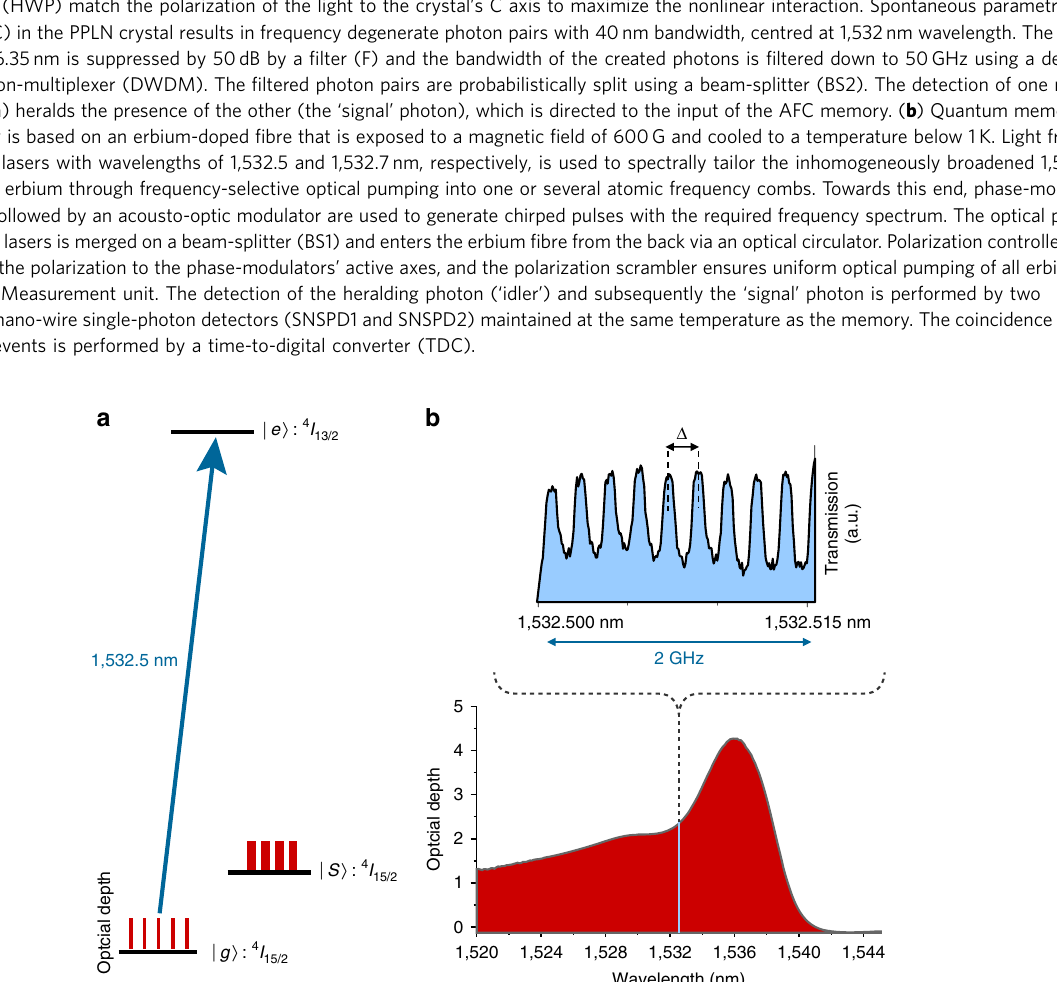
usable inhomogeneously broadened absorption line 15 , which allows for multimode storage and manipulation of photons with large bandwidth, as detailed below. Finally, we detect the heralded photons after storage/ manipulation using a second SNSPD, featuring similar performance as that used to detect the heralding photon. All detection signals are sent to a time-to-digital converter (TDC) to